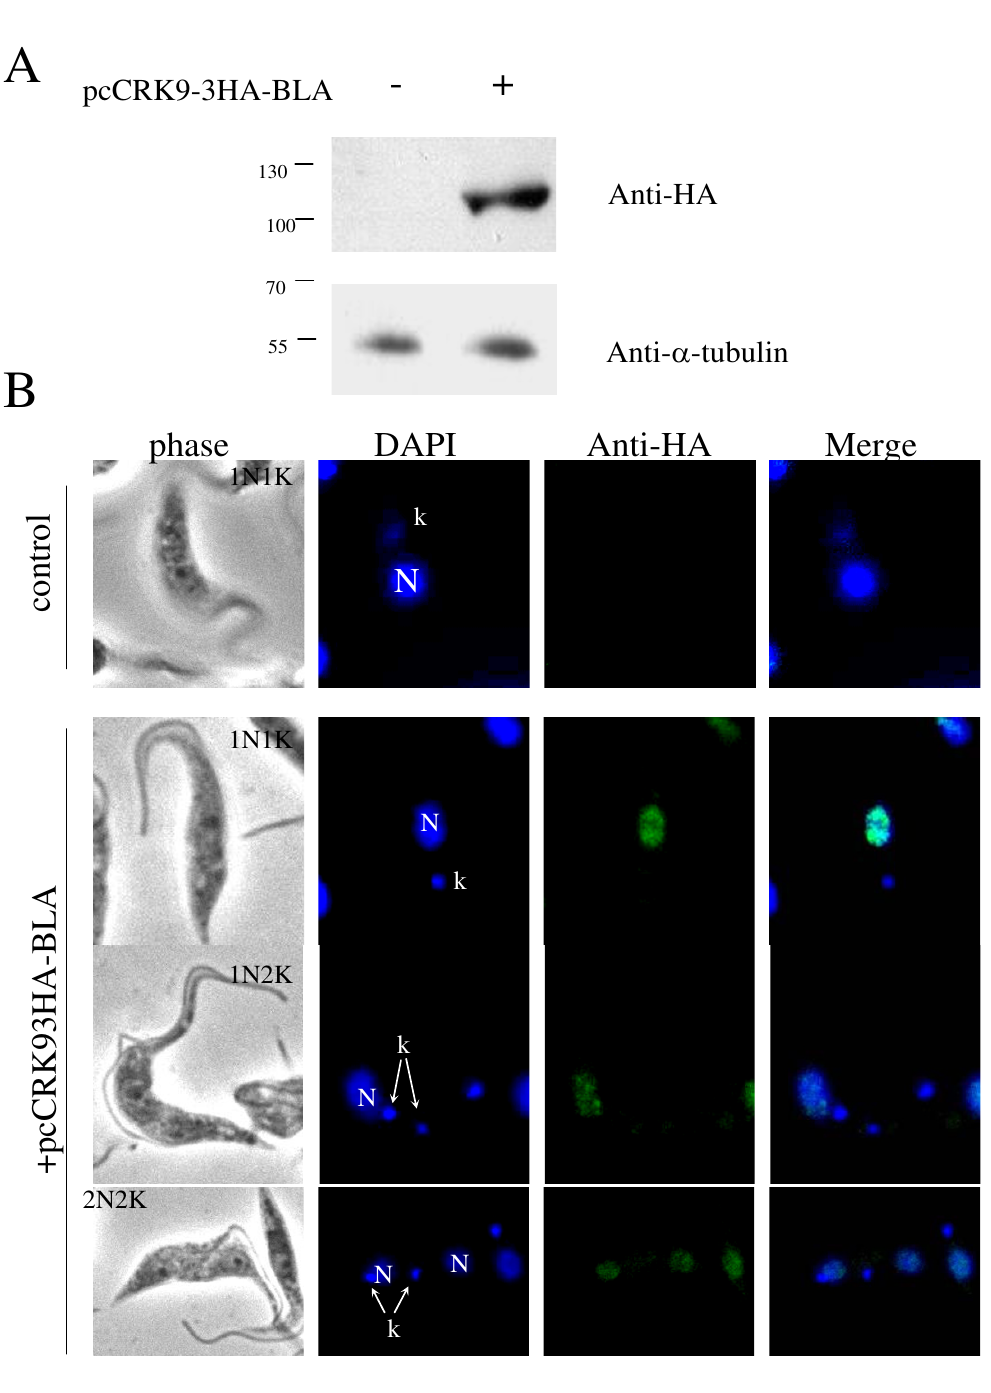
Figure 5 Localization of CRK9 in procyclic cells . CRK9 fused to the 3xHA tag was inserted into the pc-BLA-PTP vector. After lin- earization, transfection into T. brucei , and selection using blasticidin (10 g/ml), cells expressing CRK9-3HA at the endogenous level were obtained. Transfected and control cells were analyzed by Western blotting for the HA tag as indicated ( A ). The blot was also probed with anti -tubulin to verify equal sample loading. Localization of CRK9 was determined by fixing the trans- fected cells and staining them with a FITC-conjugated anti-HA antibody ( B ). DAPI was used to visualize the nucleus and kineto- plast and merged images were created using the imageJ